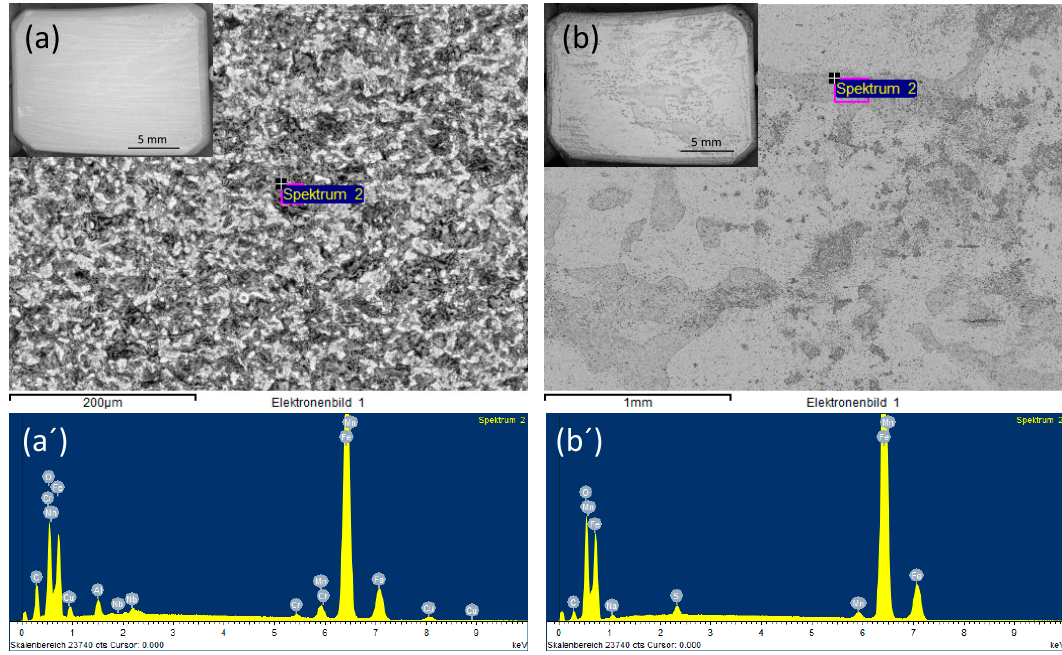
Figure 7. Backscatter electron (BSE) and EDS spectra of L360NB exposed to ( a , a’ ) 0.0184 M HNO 3 and ( b , b’ ) 0.114 M H 2 SO 4 contained condensates.